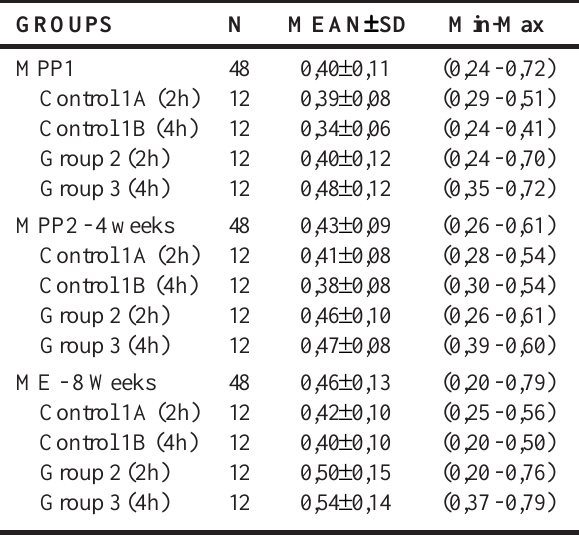
TABLE 1 - Statistics describing serum creatinine